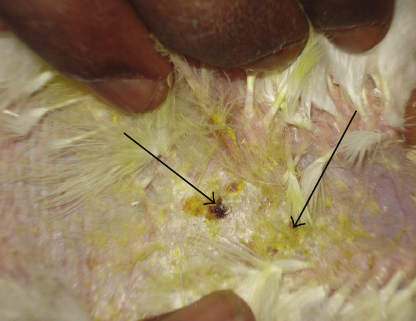
Figure 5: DTH reaction of skin (T-2 toxin plus GM fed bird): mild increase in skin thickness and scab formation compare to toxin-fed